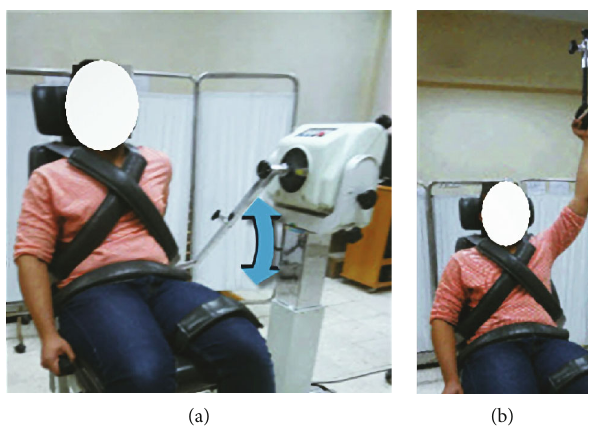
Figure 2: Shoulder abductors and adductors isokinetic testing: (a) initial position and (b) fi nal position.